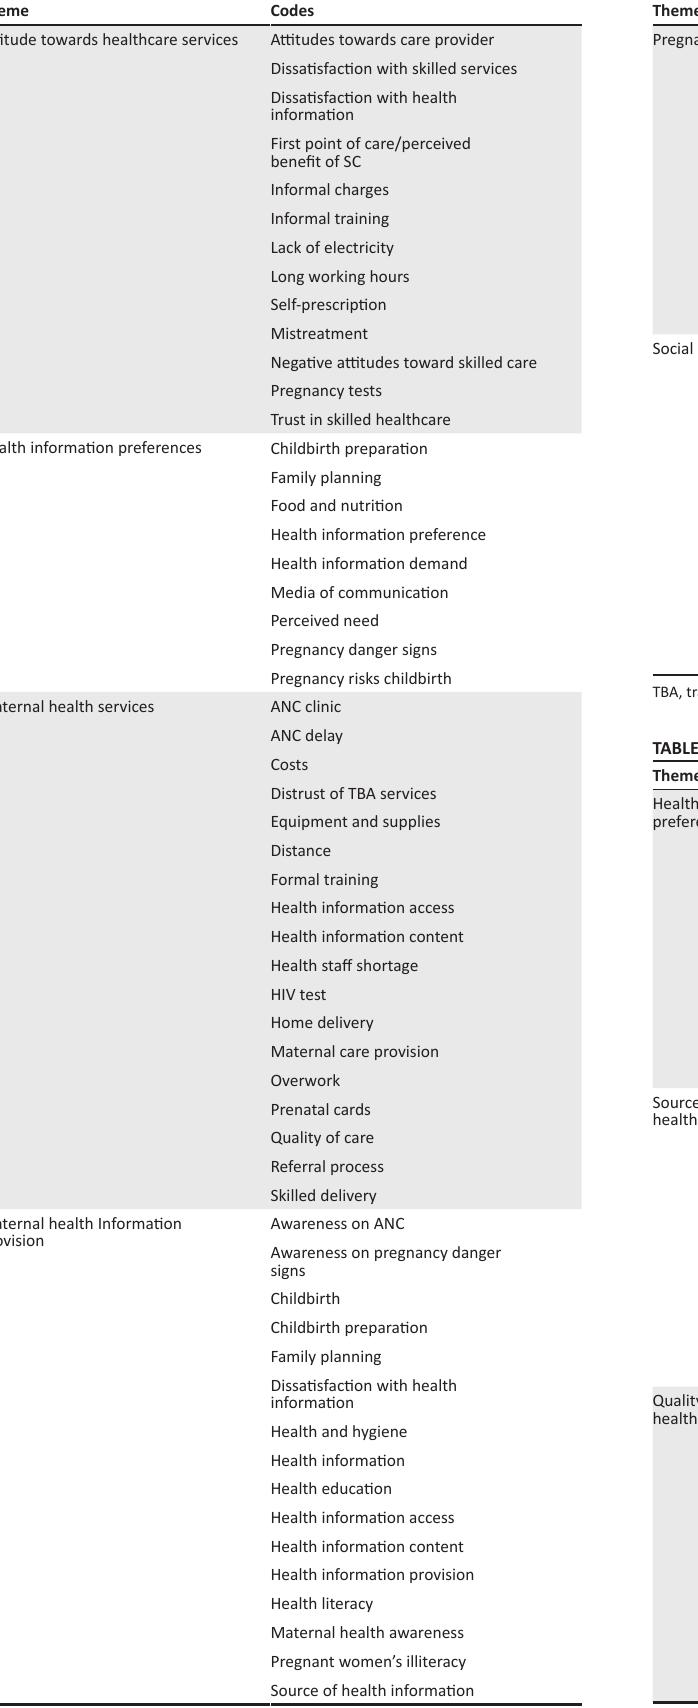
TABLE 2 (Continues...): Preliminary themes. Theme